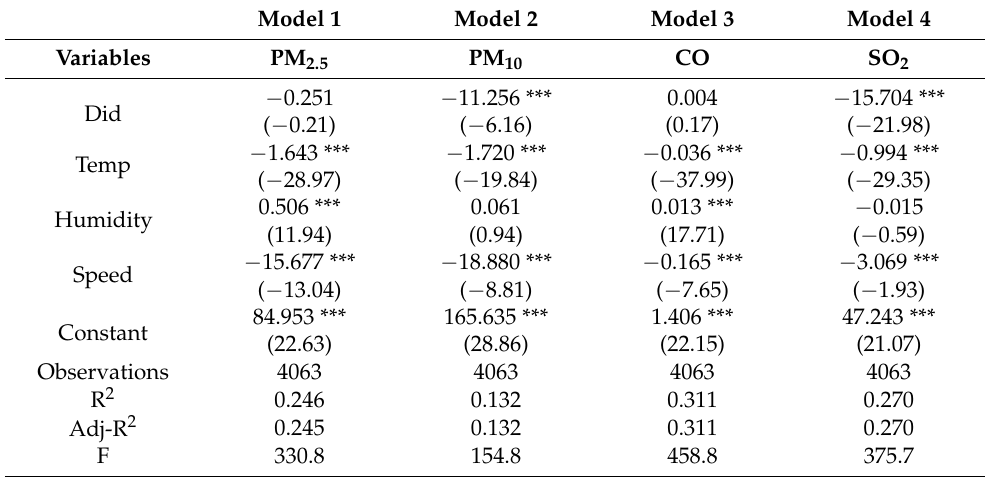
Table 9. Placebo test results.